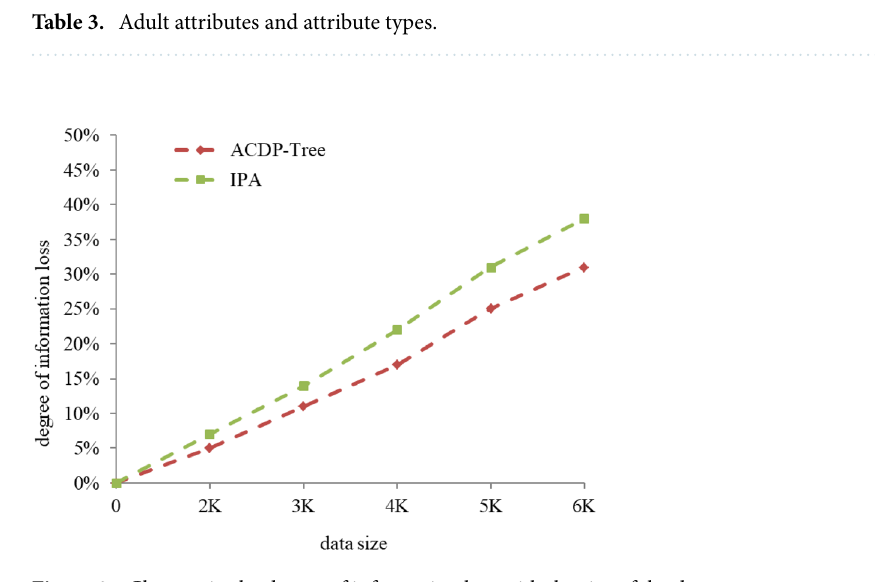
Figure 3. Changes in the degree of information loss with the size of the